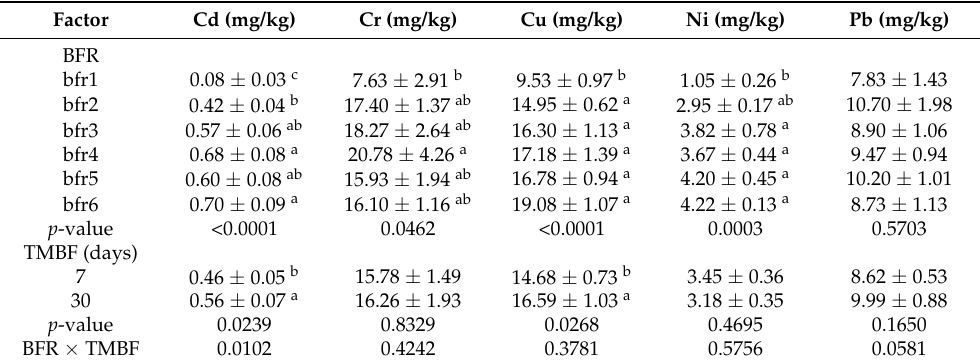
Table 5. Main and interaction effects of bokashi fertilizer ratios and time of bokashi fertilizer matu ‐ ration on some selected heavy metals.